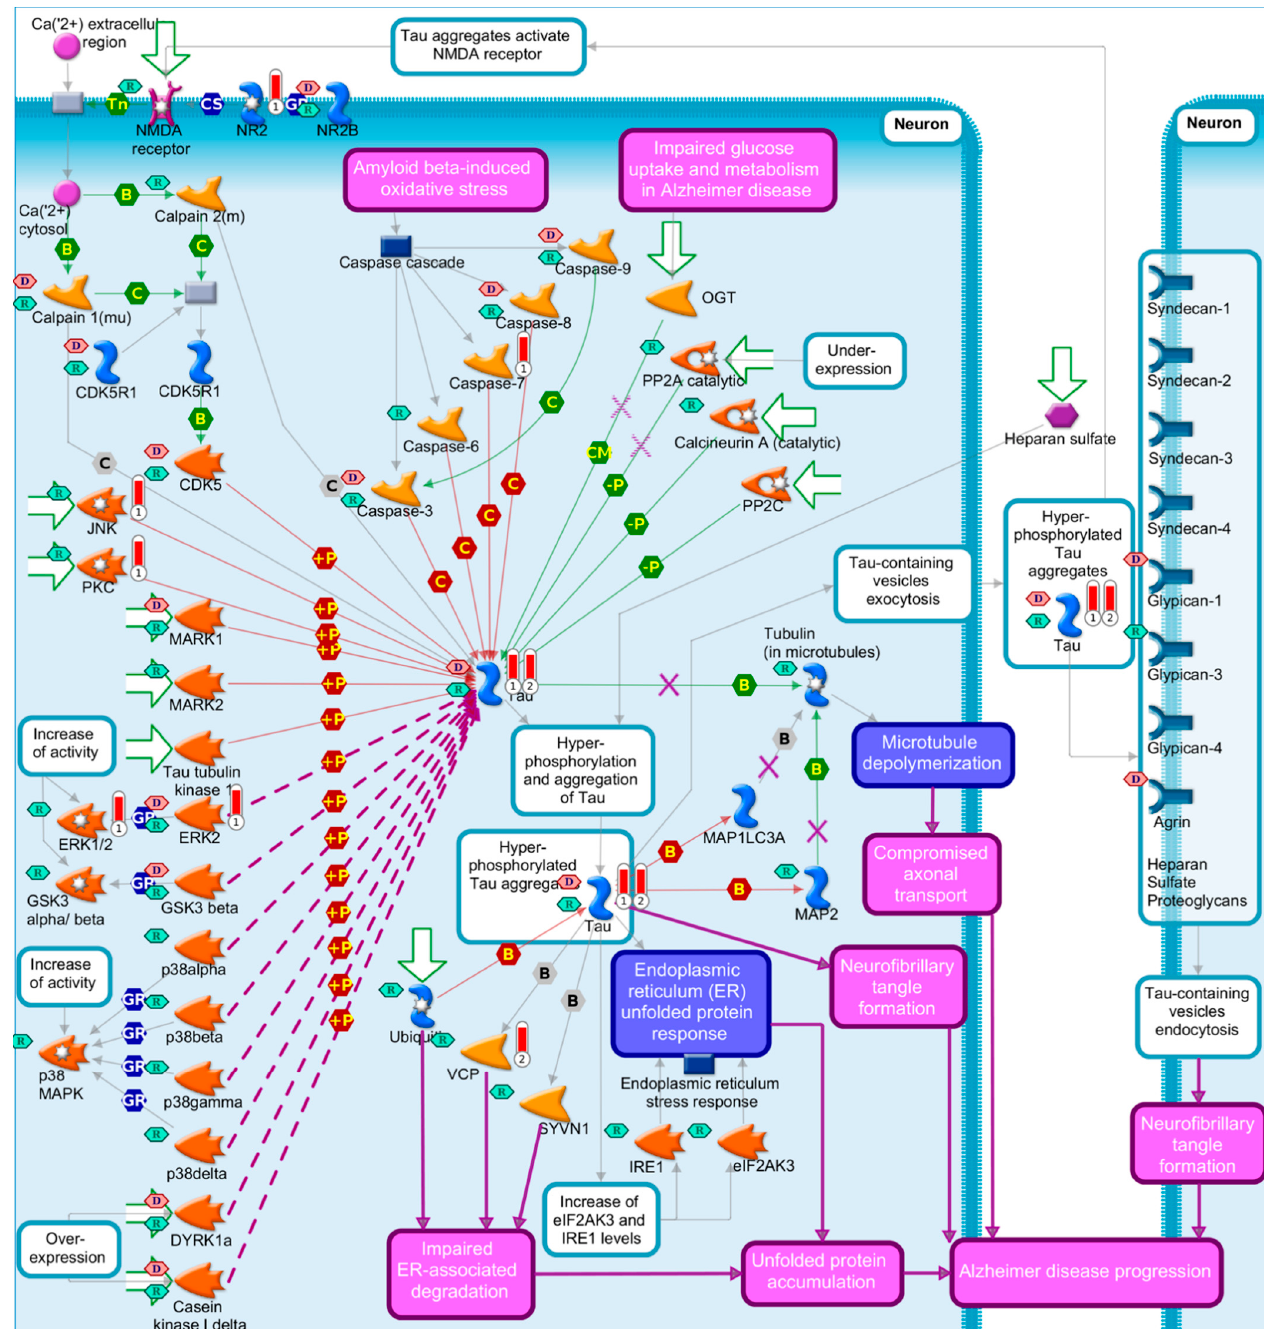
Figure 1. Alzheimer’s disease (AD) pathway map highlighting validated diagnostic/prognostic AD biomarkers in addition to genes/gene products involved in the tau pathology pathway. Connections between network objects on the map are referred to as links (or edges). A link identifies an interaction or a logical relation between two nodes. The type of interaction or relation is reflected by an appropriate symbol placed in the middle of the link. B = binding (i.e., physical interaction between molecules); C = cleavage; CM = covalent modification; +P = phosphorylation; -P = dephosphorylation; Tn = transport; TR = transcription regulation; red arrows = inhibition; green arrows = activation; grey arrows = unspecified action; solid purple arrows = emergence in disease; dashed purple arrows = enhancement in disease; arrows with purple x = disruption in disease; light violet text box = normal process; pink text box = pathological processes; white text box with blue outline = notes; grey block = reaction; blue block = normal process; pink block = pathological process; solid purple hexagon = compound; CS = complex subunit; GR = group relation; starred network objects = groups or complex